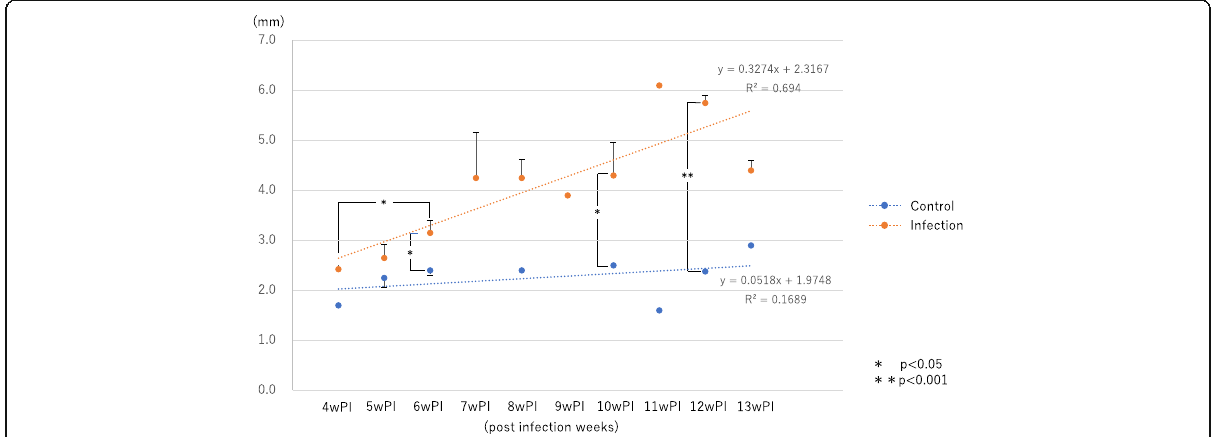
Fig. 7 Depth of the spleen. The depth of the spleen was gradually enlarged from 4 weeks PI and then continued to